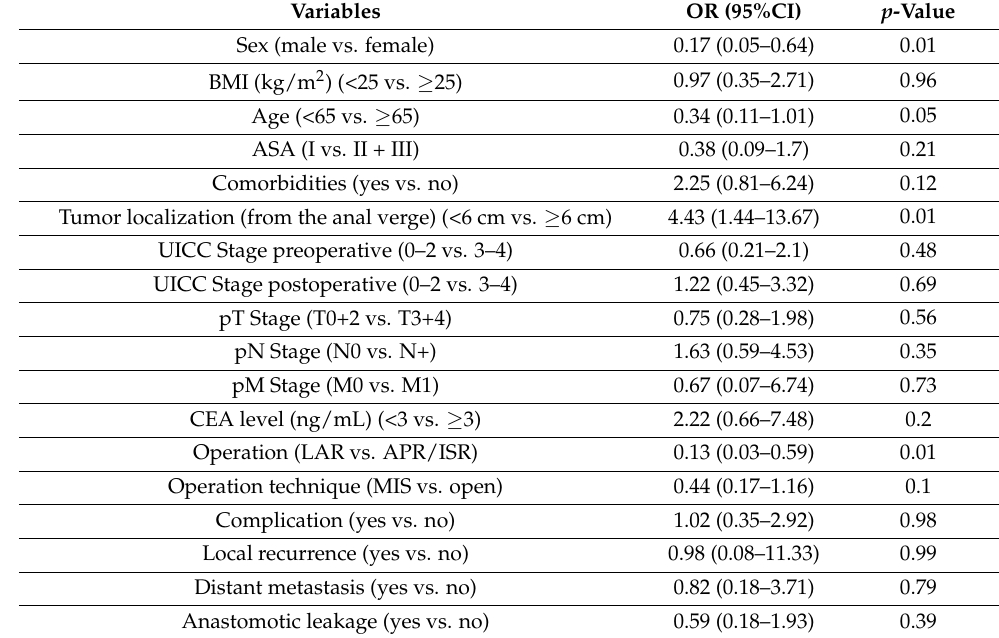
Table 3. Univariate analysis of potential risk factors for sexual dysfunction after rectal cancer